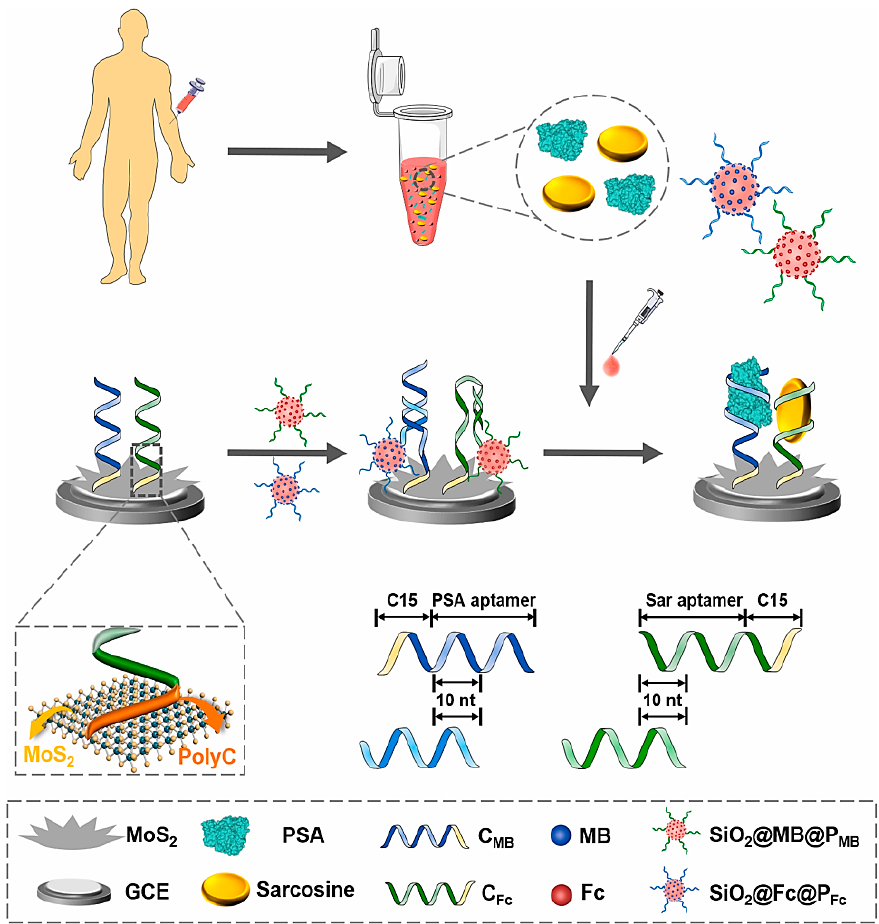
Figure 3. Schematic representation of electrochemical aptasensors for the one-step, simultaneous detection of two prostate cancer biomarkers using nanoflower-like MoS 2 functional interfaces and signal-amplified SiO 2 nanoprobes. Reprinted from [27] with permission.